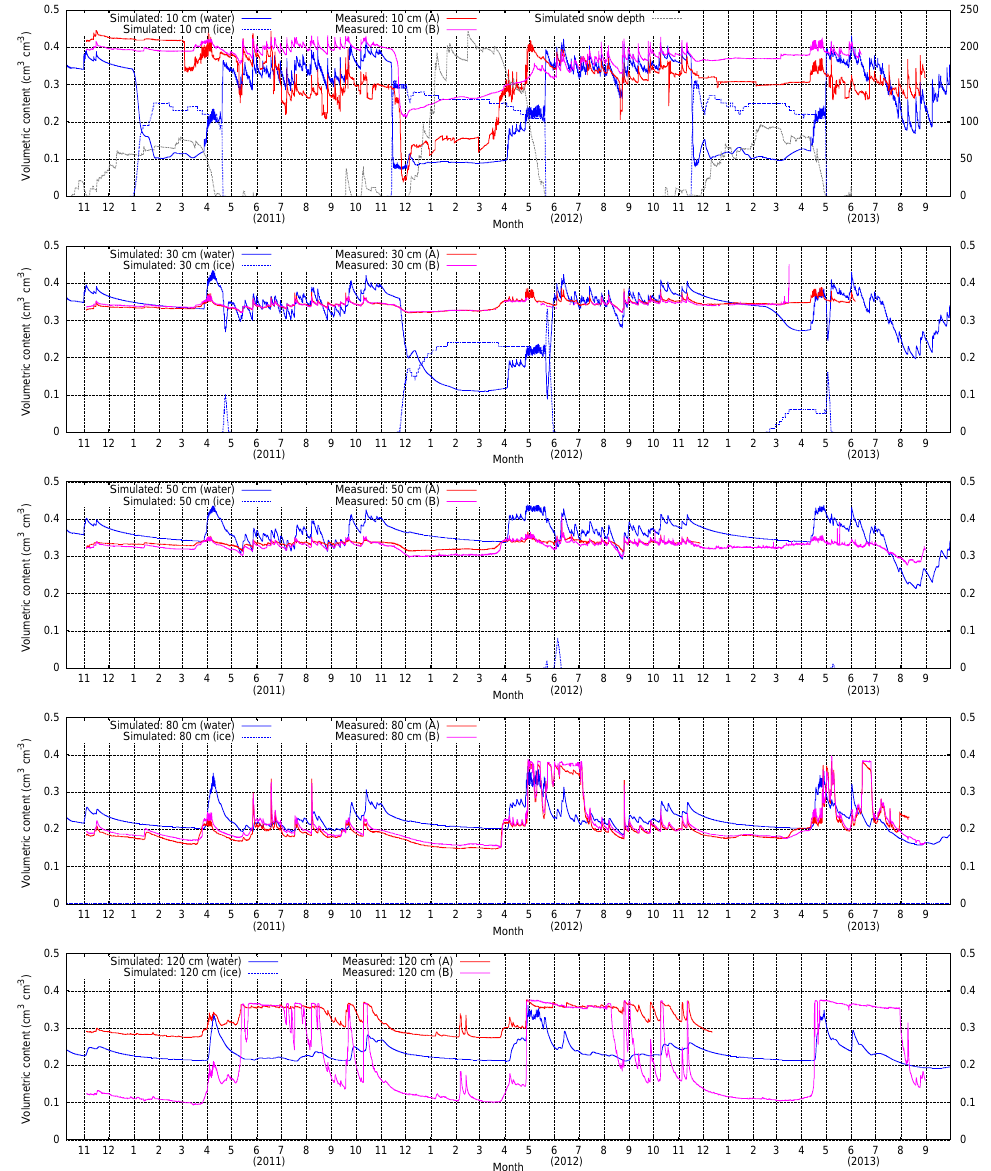
Figure 6. Measured and simulated soil moisture at the IRKIS station Uf den Chaiseren, for (from top to bottom) 10, 30, 50, 80 and 120cm depths for the period October 2010 to October 2013. In the upper panel, simulated snow depth is also shown.